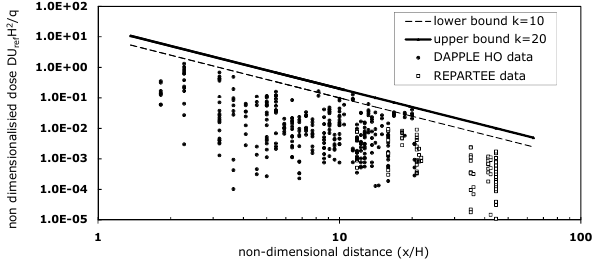
Fig. 7. Evaluation of simple correlation model based on experi- mental data from both REPARTEE and DAPPLE HO campaigns centred in